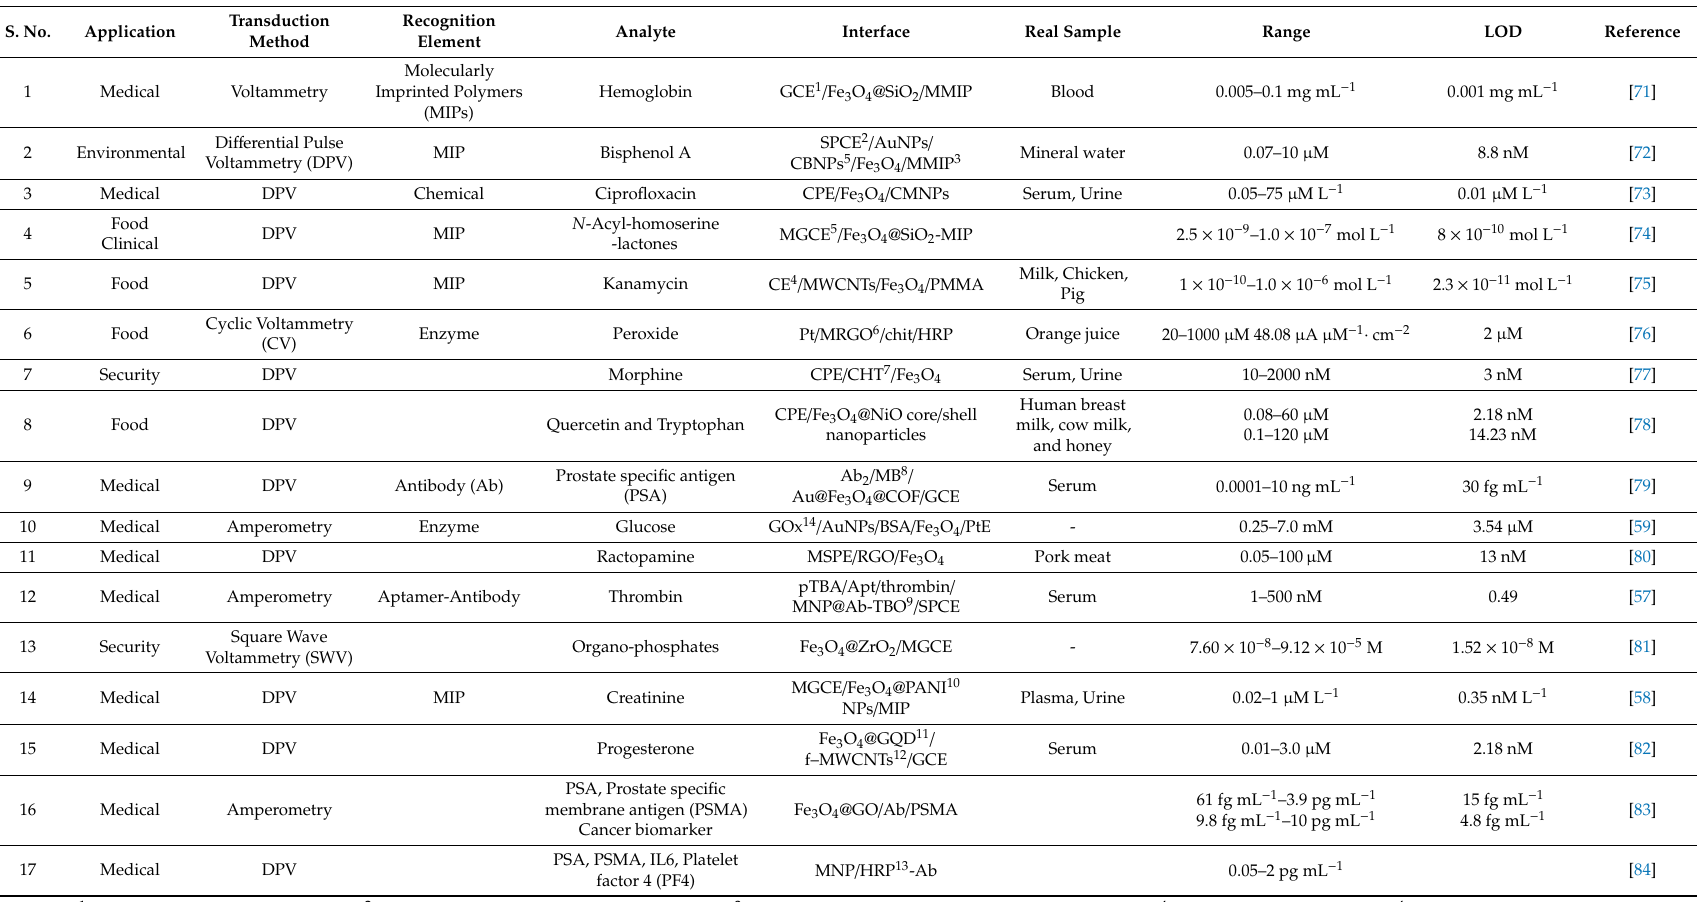
Table 1. Magnetic nanoparticle (MNP)-based electrochemical sensors for the detection of various analytes. S.